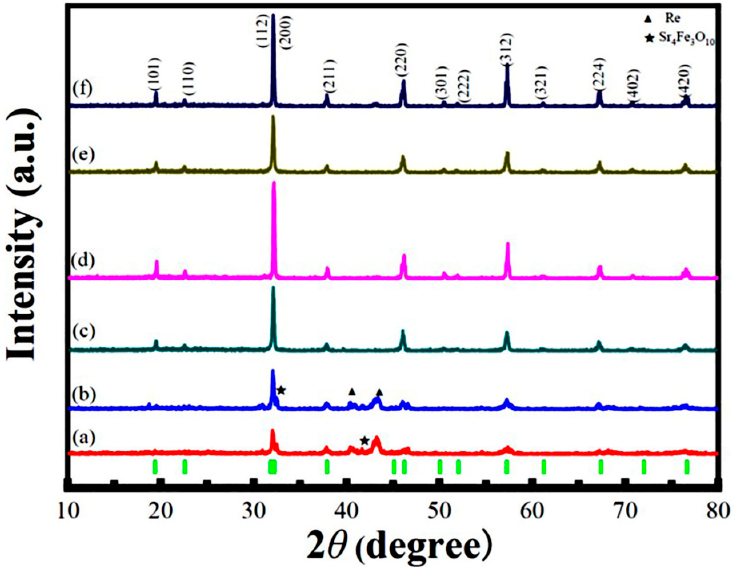
Figure 1. Room temperature XRD patterns of the SFRO powders annealed for 12 h at different temperatures and atmospheres. ( a ) 800 °C, ( b ) 900 °C, ( c ) 1000 °C, ( d ) 1100 °C under N 2 atmosphere, ( e ) 1100 °C under Ar atmosphere, and ( f ) 1200 °C under N 2 atmosphere. The green tick marks represent the positions of the allowed Bragg reflections. To obtain the structural parameters, Rietveld refinement on the experimental XRD data of sample B (SFRO powders annealed at 1100 °C under N 2 atmospheres) was per- formed. The refined XRD pattern is shown in Figure 2, where the red solid line indicates the simulated diffractogram, the black cross symbols correspond to the experimental data, the blue line represents the difference between the experimental and theoretical patterns, and the green line refers to the background. The short vertical lines represent the positions of the allowed Bragg reflections. All diffraction peaks can be well indexed in a I 4 /m tetrag- onal structure without any detected impurities. The quality of Rietveld refinement in this